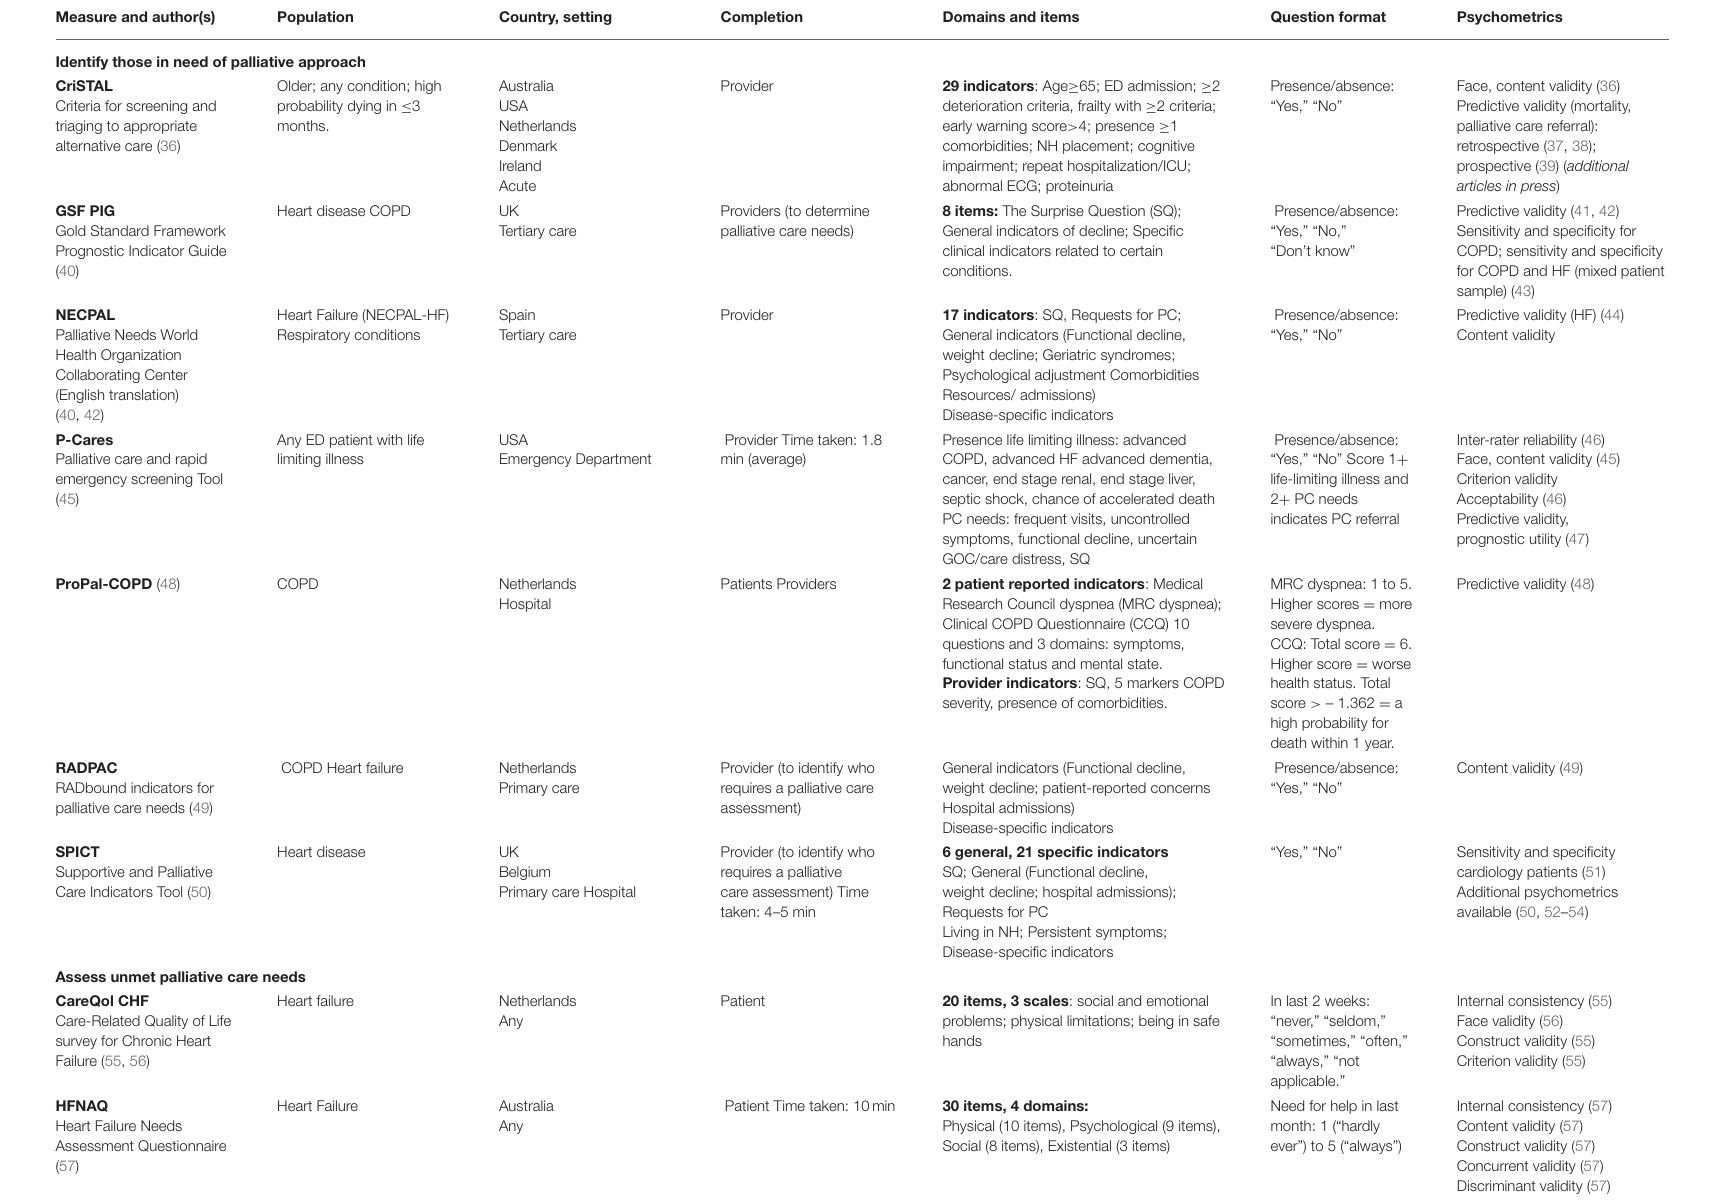
TABLE 1 | Study and sample characteristics used to develop and/or psychometrically test identified